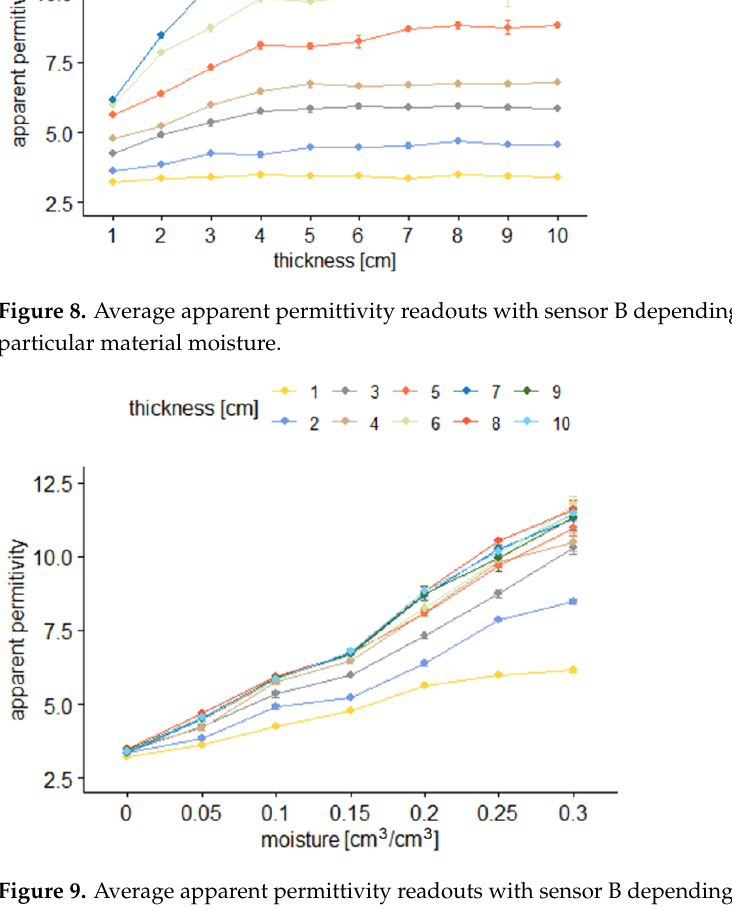
Figure 9. Average apparent permittivity readouts with sensor B depending on the material moisture for particular sample thickness.